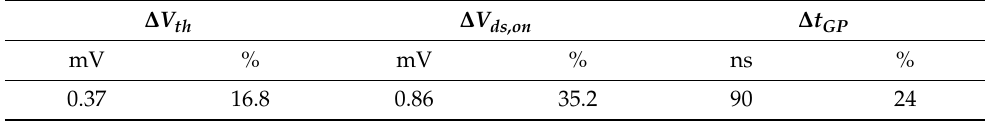
Table 3. Comparison of different failure precursors.